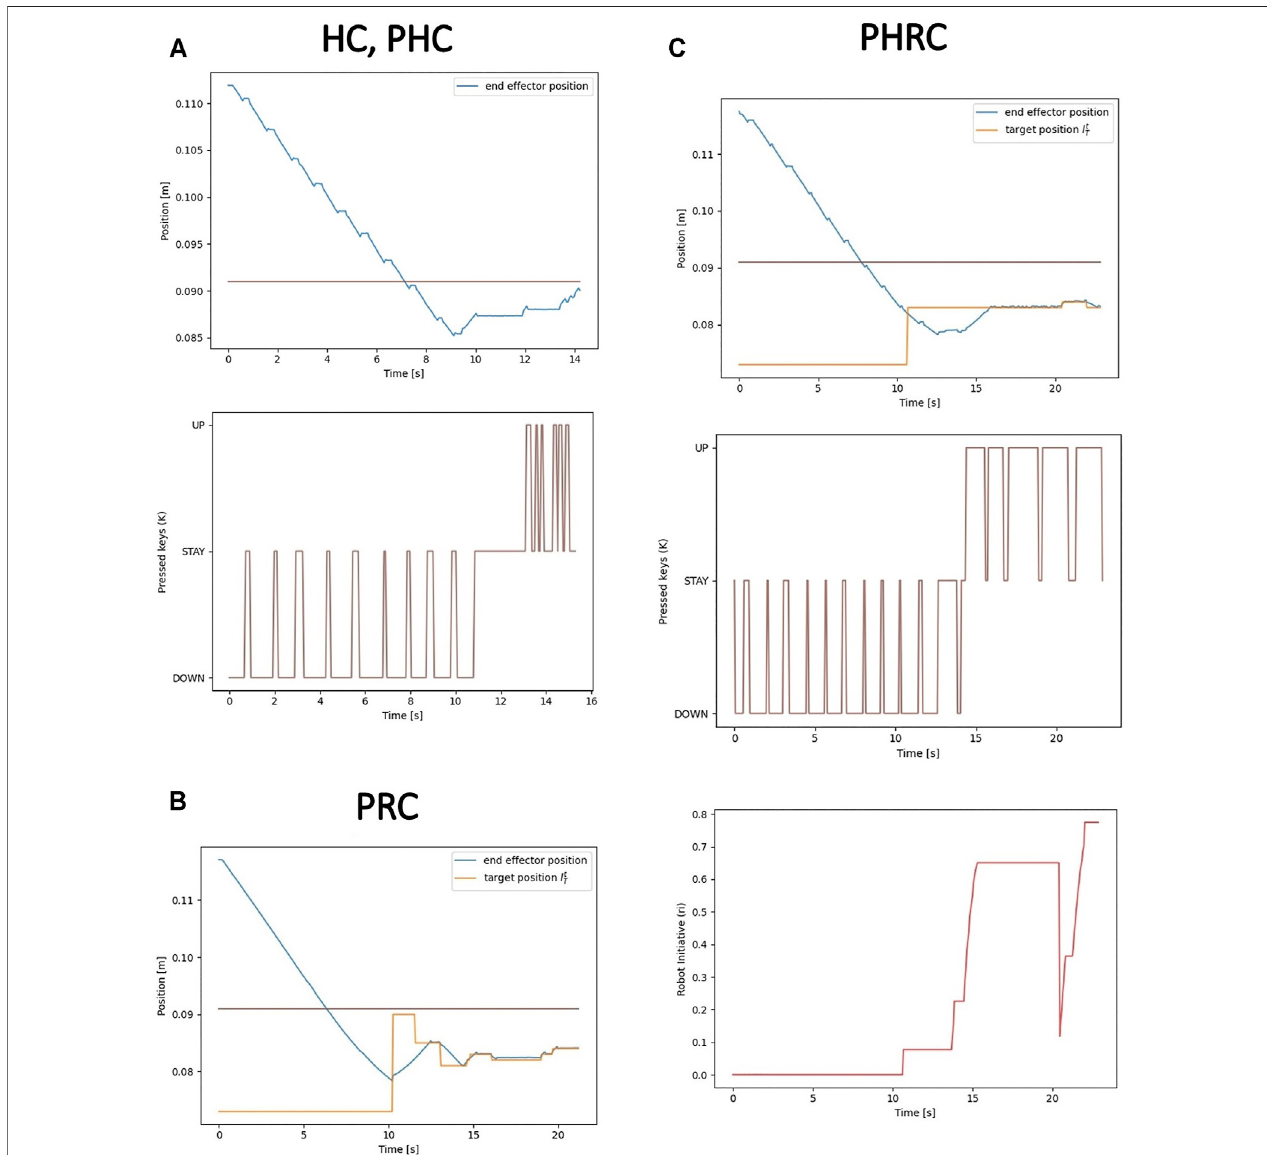
FIGURE5 | Examples ofthe differentcontrolling modalities in0 sdelay condition. In HC and PHC , the motion isentirely controlled by the keyboard inputs given by the user (A) . In PRC , the input is completely ignored and the robot is driven toward the target position determined by the internal model (B) . In PHRC , both the target positionandtheinputkeys areusedtodeterminethemotorcommandgiventotherobot,accordingto Eq.8(C) .Inthetrajectories ’ plots,thehorizontallineistheheight at which the top surface of the dummy is positioned.